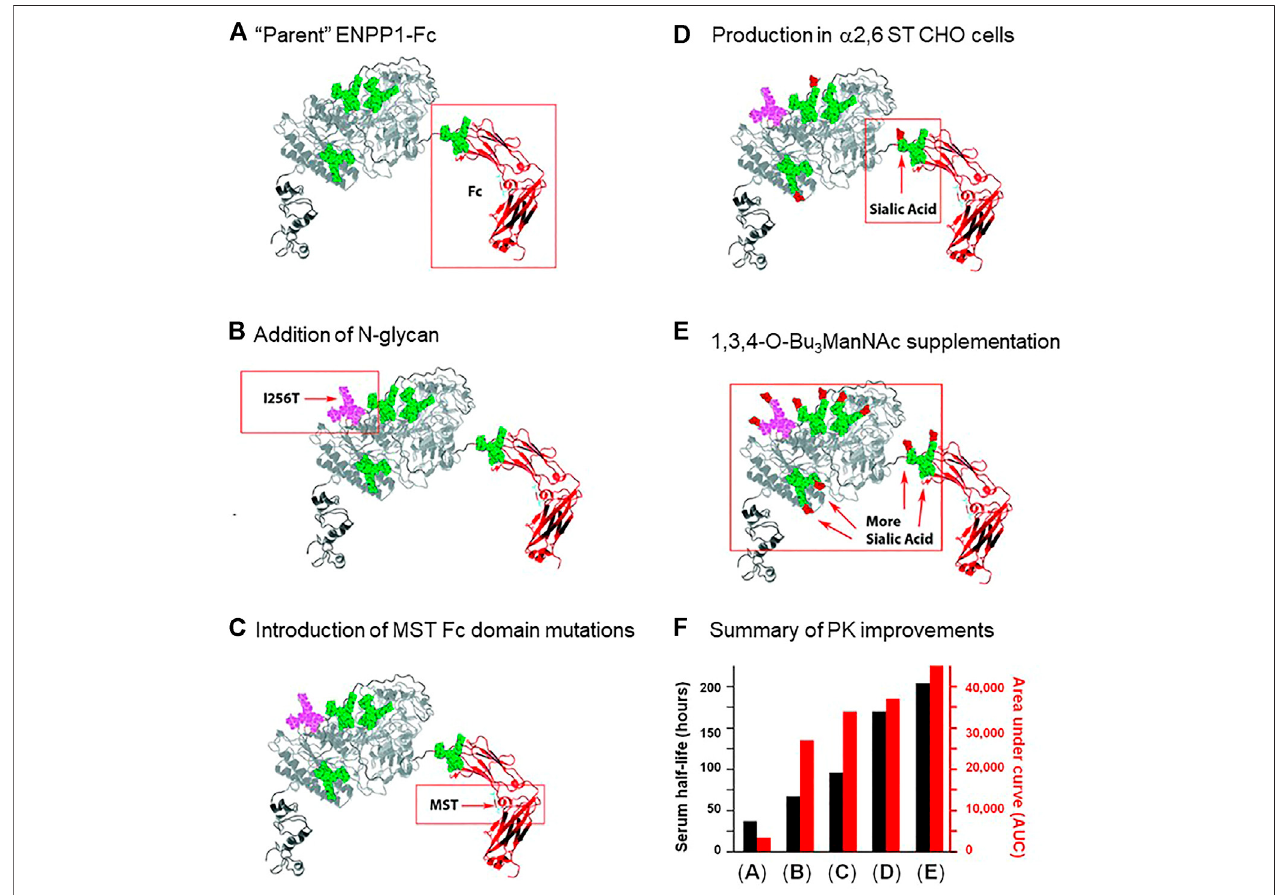
FIGURE 3 | ENPP1 protein and glycoengineering. Improvements made to the pharmacokinetics of ENPP1 as reported by Stabach and coauthors (Stabach et al., 2021)aresummarizedinthis fi gure. (A) First,inpreviouswork(Albrightetal.,2016),theenzymewasfusedtotheimmunoglobulinFcdomaintoincreaseproteinrecycling andserumrecirculationthroughinteractionswiththeneonatalFcreceptor(Albrightetal.,2016);this “ parent ” constructhadaserumhalf-lifeof37 handanAUCof3,400 as depicted graphically in Panel (F) . (B) Addition of an N-glycan site was achieved through the I256T mutation to ENPP1 resulting in addition of the glycan to Asn254; this newly added N-glycan approximately doubled serum half-life and octupled the AUC value. (C) Mutation of Met, Ser, and Thr (MST) that increase af fi nity for the neonatal Fc receptor (Vaccaro et al., 2005) were introduced into ENPP1-Fc Fc ’ s domain, further improving both serum half-life and AUC. Finally, two approaches to increase sialylation including (D) production of ENPP1-Fc in α 2,6-sialyltransferase overexpressing CHO cells and (E) supplementation of the culture medium with the sialic acid metabolic precursor 1,3,4-O-Bu 3 ManNAc sequentially further increased serum half-life (to a fi nal value of 204 h) and the AUC value (to 45,000).